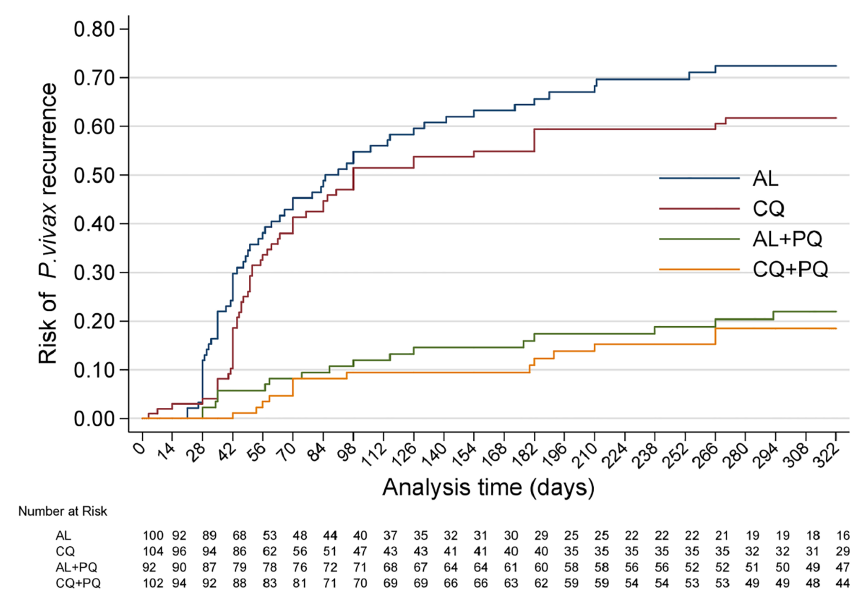
Fig 2. Cumulative risk of P . vivax recurrencein all four treatment arms over the entire follow-up time. AL, artemether-lumefantrine; AL+PQ, artemether-lumefantrine + primaquine;CQ, chloroquine;CQ+PQ, chloroquine + primaquine.